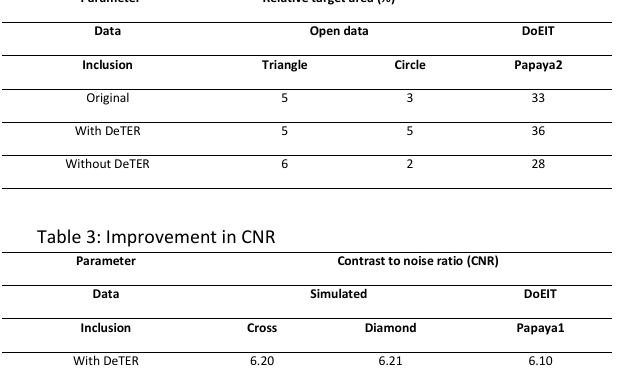
Comparison with TV method